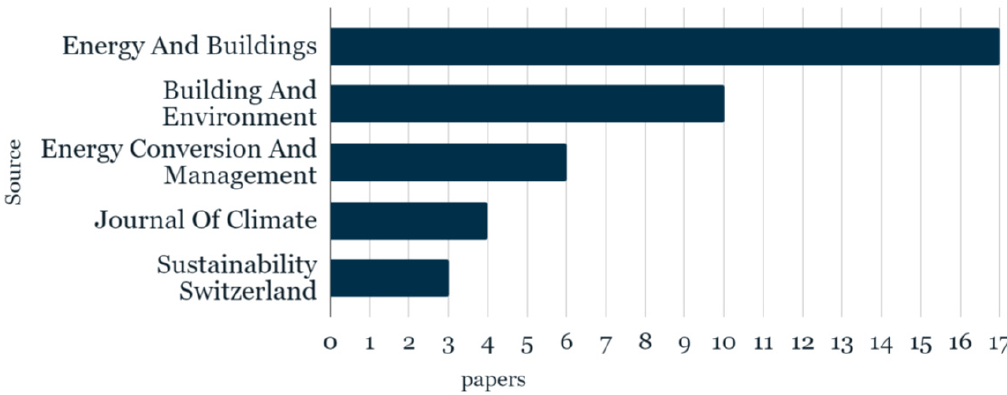
Figure 14. The bar chart of the journals that published CZB papers.